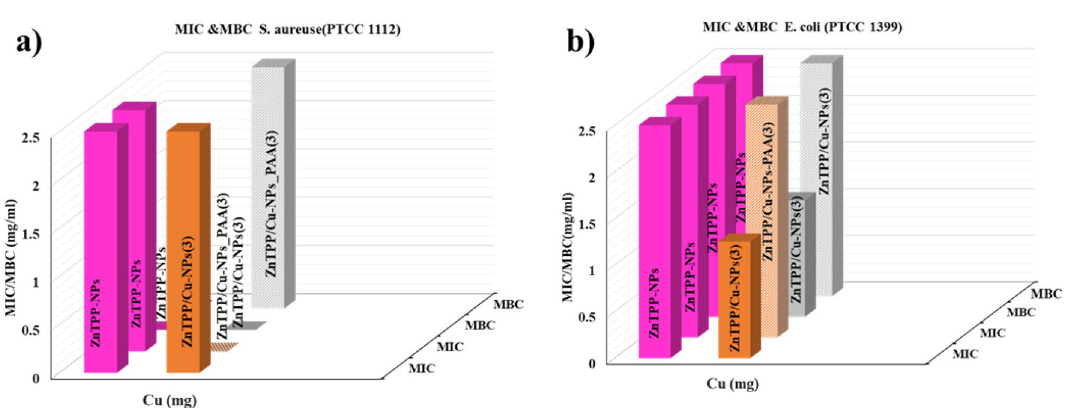
Figure 13. Column chart representing MIC and MBC values of S. aureus (PTCC1112) and E. coli (PTCC1399).